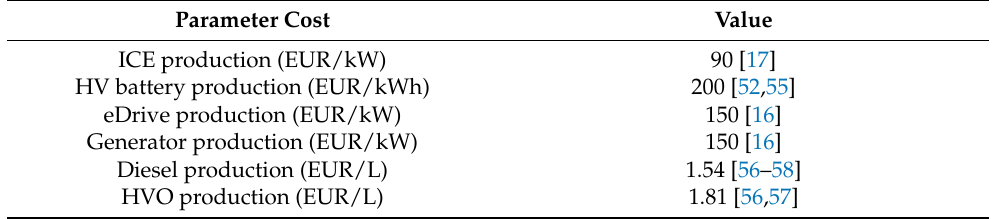
Table 6. Production and fuel cost assumptions for total cost of ownership (TCO)